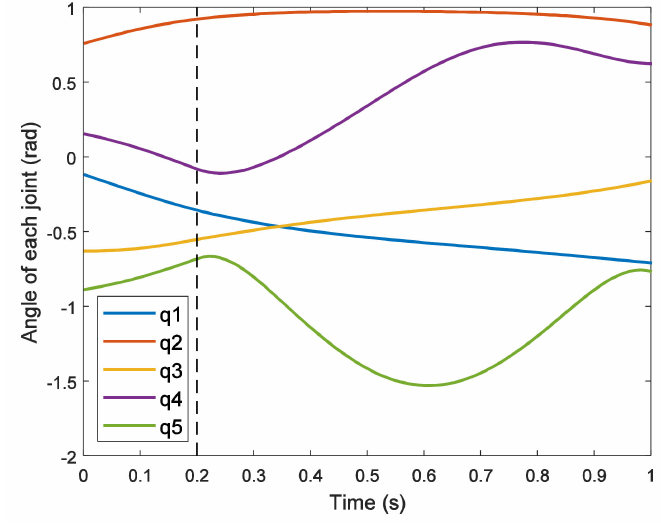
Figure 4. Angle trajectories.